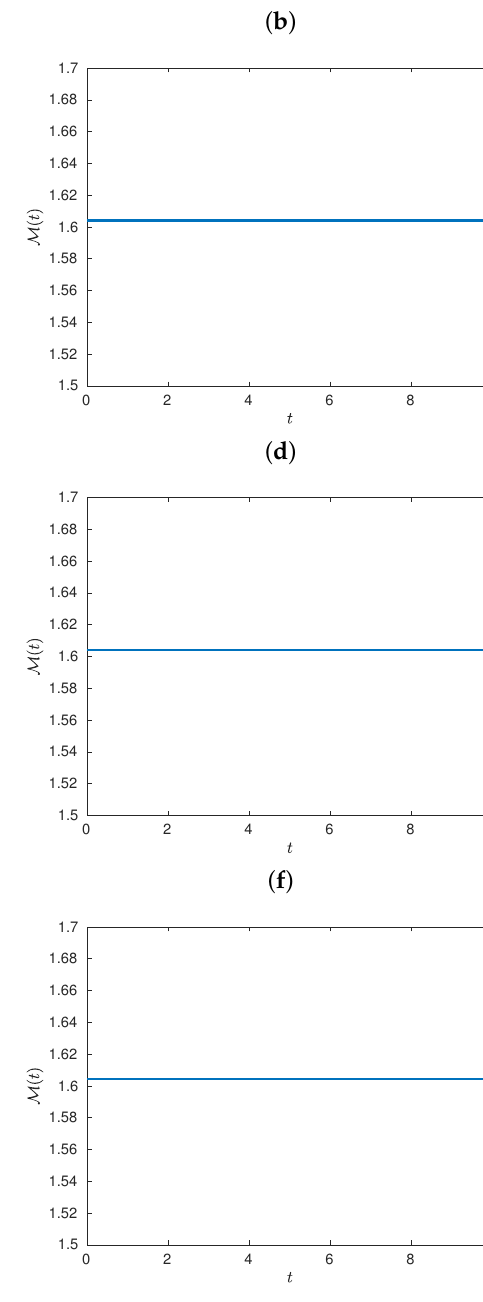
x 2 , and initial data φ 1 ( x ) = φ 2 ( x ) = 2